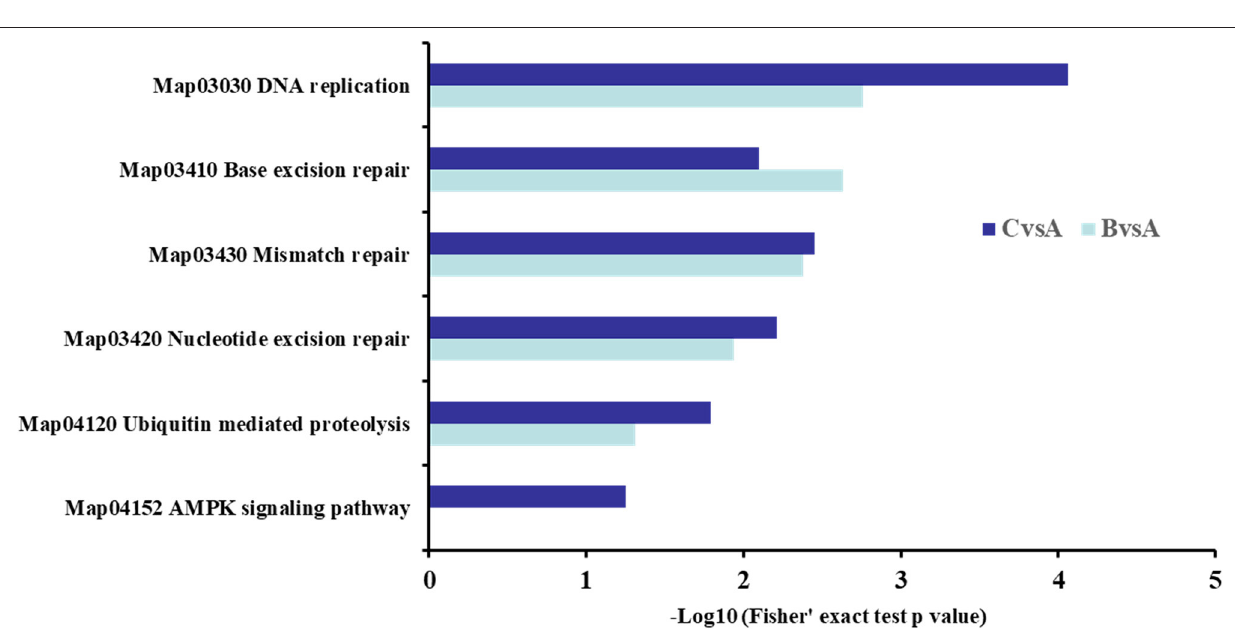
that mainly enriched in AMPK signal pathway, including